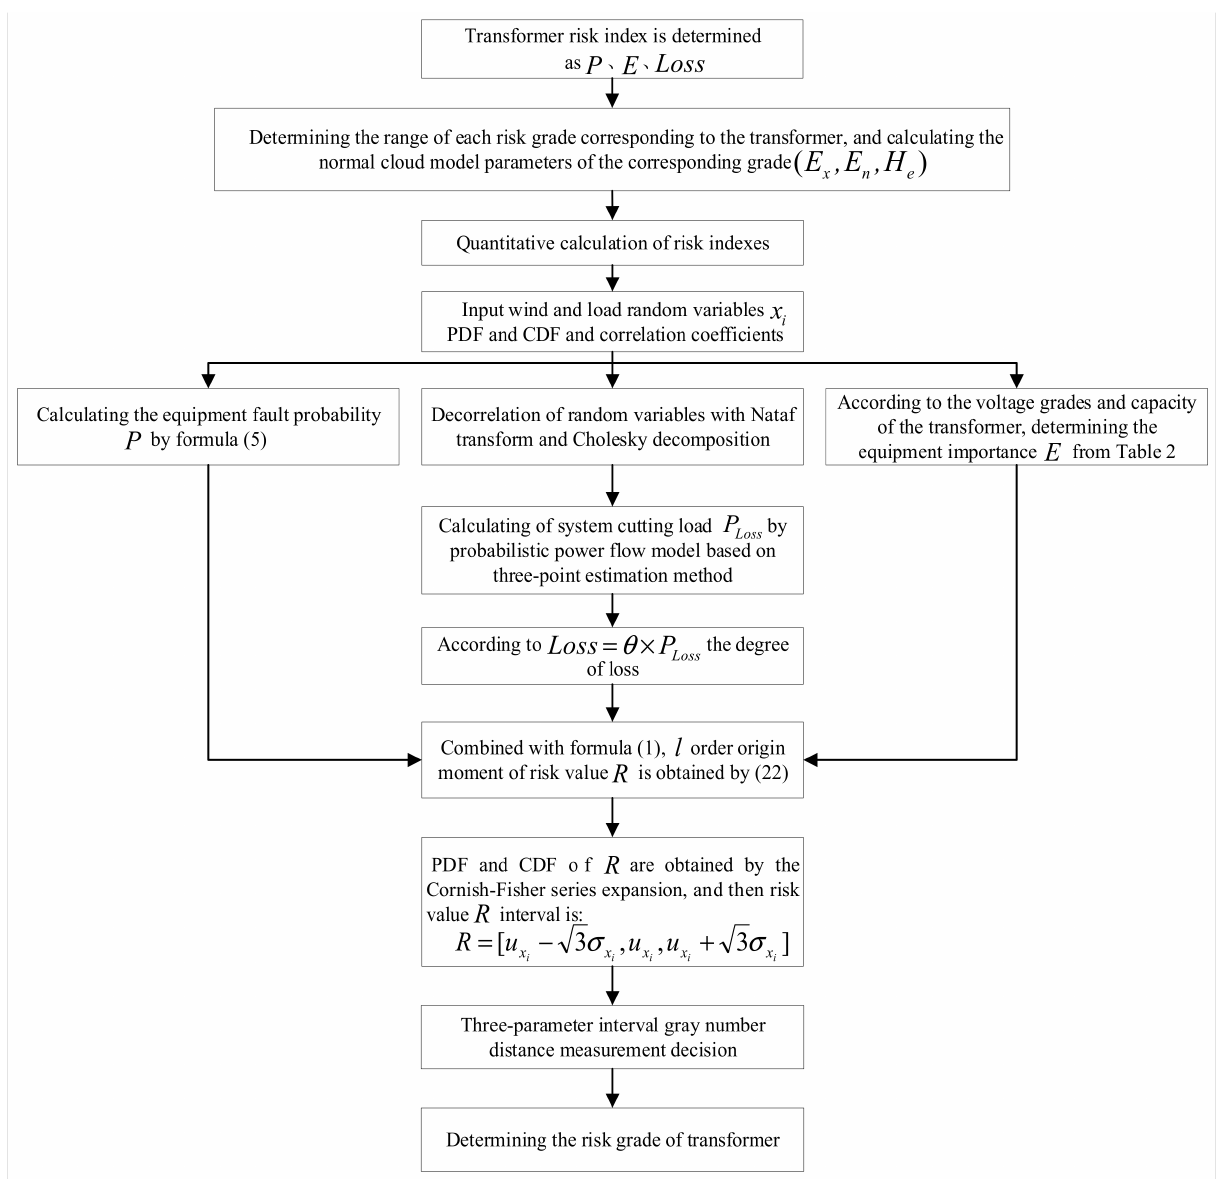
Figure 2. Risk assessment process for a power